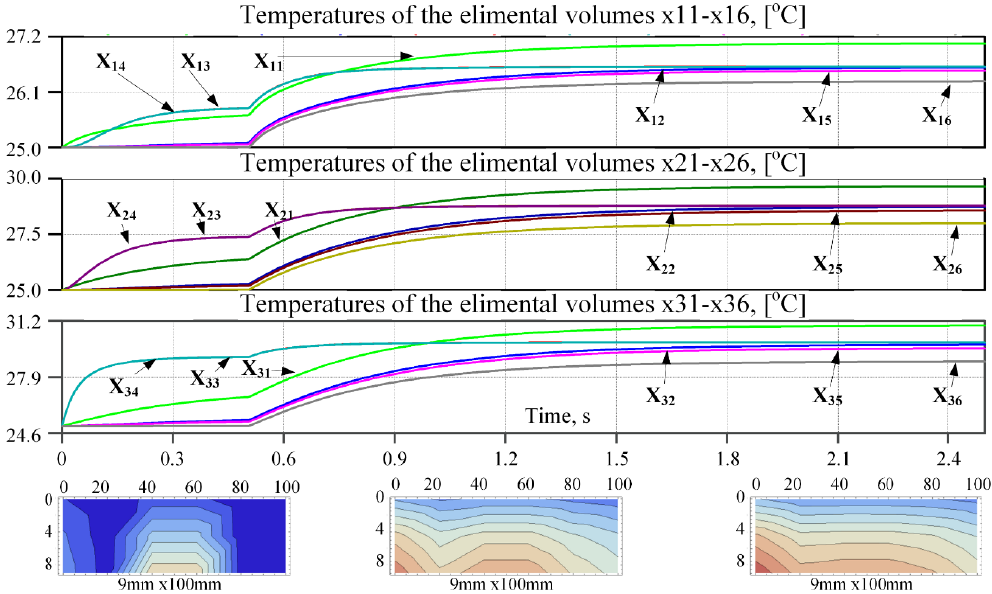
Figure 10. Equivalent voltages representing the temperatures of the central points of each of the 18 elemental volumes. The 1 V of equivalent voltage corresponds to 1 °C . The three plot-panes correspond to three rows of the mesh. The temperature gradient plots correspond to 0.3 s, 1.2 s, and 2.3 s are shown below the time response curves.